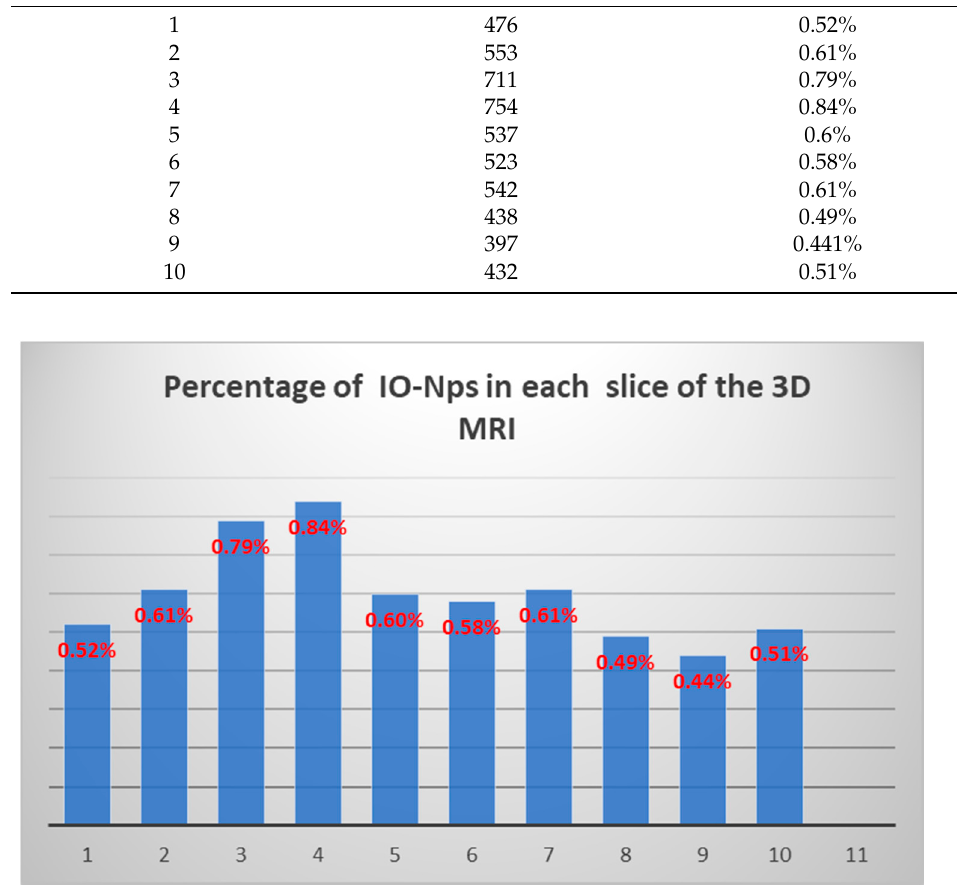
Table 1. Displays numbers and percentage of white pixels, considered IO-NPs, in 10 slices from the ( c ) ( d ) 3D of MRI images. Figure 5. ( a ) Shows the 3D slice of the mouse calf region; ( b ) shows the binary version of ( a ); and ( c ) shows the results of morphological operation on ( b ); and ( d ) shows the final results of extracted IO- NPs.